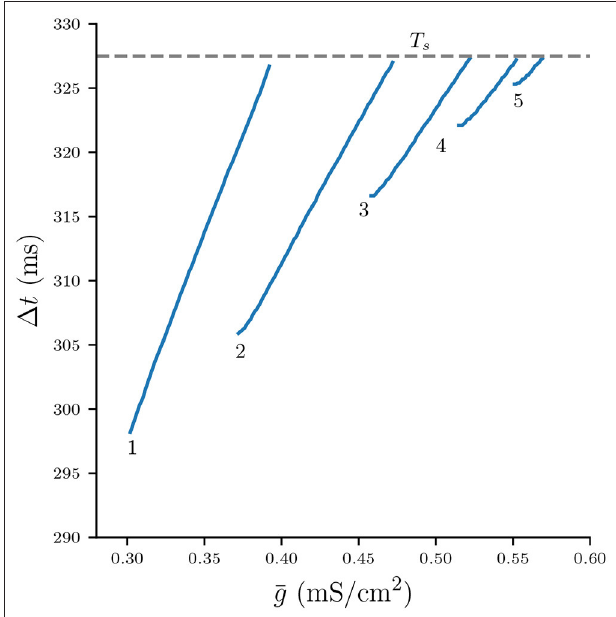
FIGURE 6 | Numerically computed bifurcation diagram of 1 t for varying ¯ g . Each continuous branch is associated with a stable n : n burst solution. Increasing ¯ g increases 1 t until the solutions bifurcate at 1 t ≈ T s